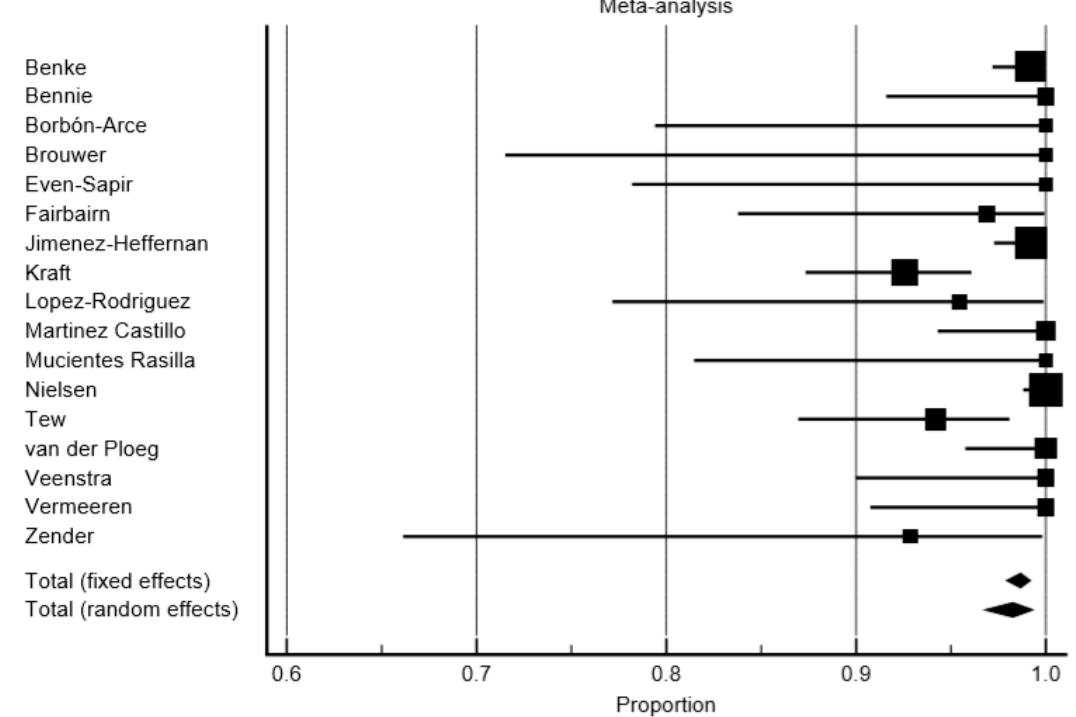
Figure 3. Forest plot of the detection rate (DR) of sentinel lymph nodes (SLNs) on single photon emission computed tomography/computed tomography (SPECT/CT).